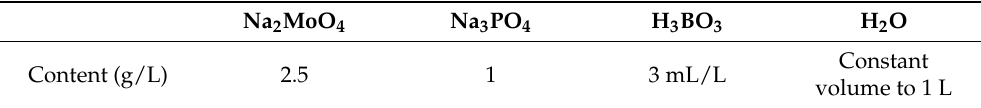
Table 2. Low phosphorus passivated solution formula.